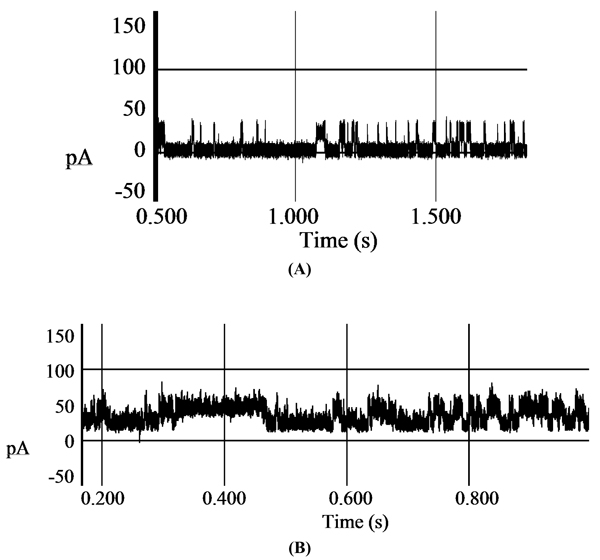
(A) Blockade due to T6 antibody. (B) T6 antibody blockade one minute after exposure to antigen.